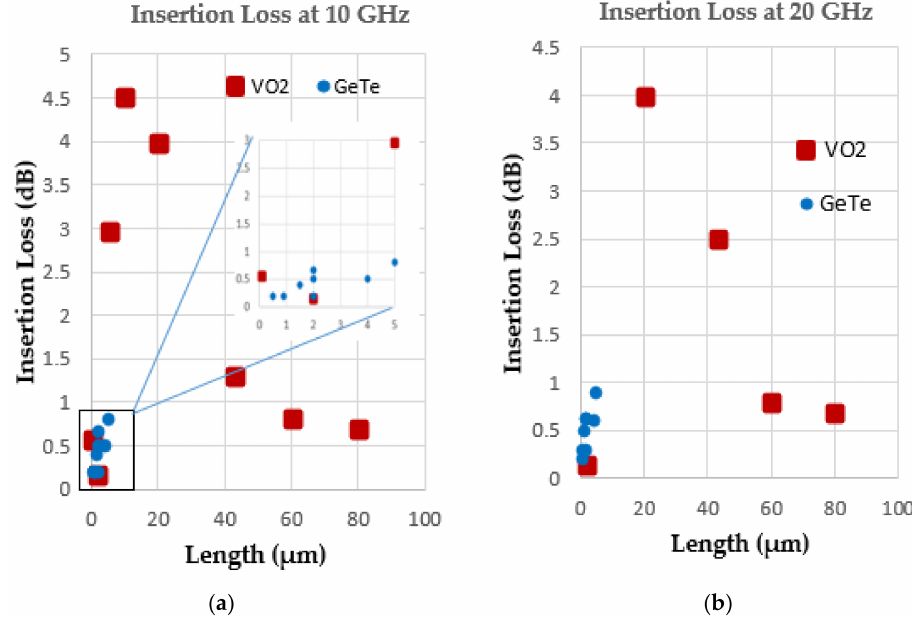
Figure 15. Insertion losses associated with each reported device active lengths. ( a ) Insertion loss at 10 GHz; ( b ) Insertion loss at 20